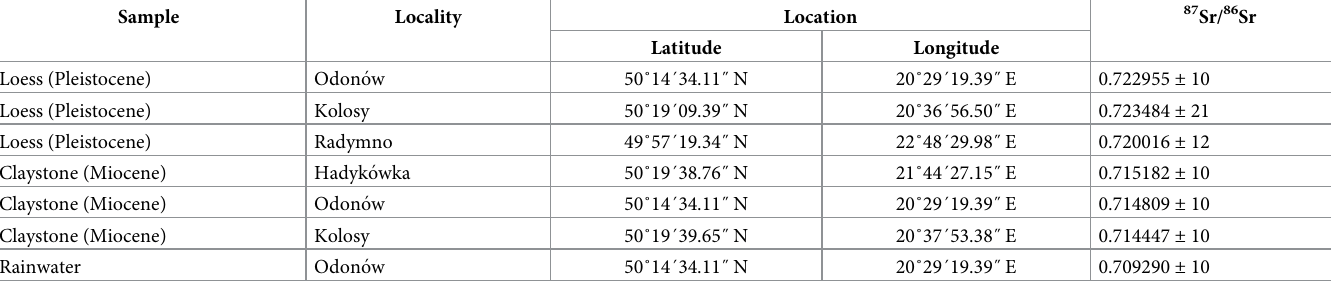
Table 4. Strontium isotope signatures ( 87 Sr/ 86 Sr) of bedrock and rainwater in the studied areas of south-western Poland. Sample